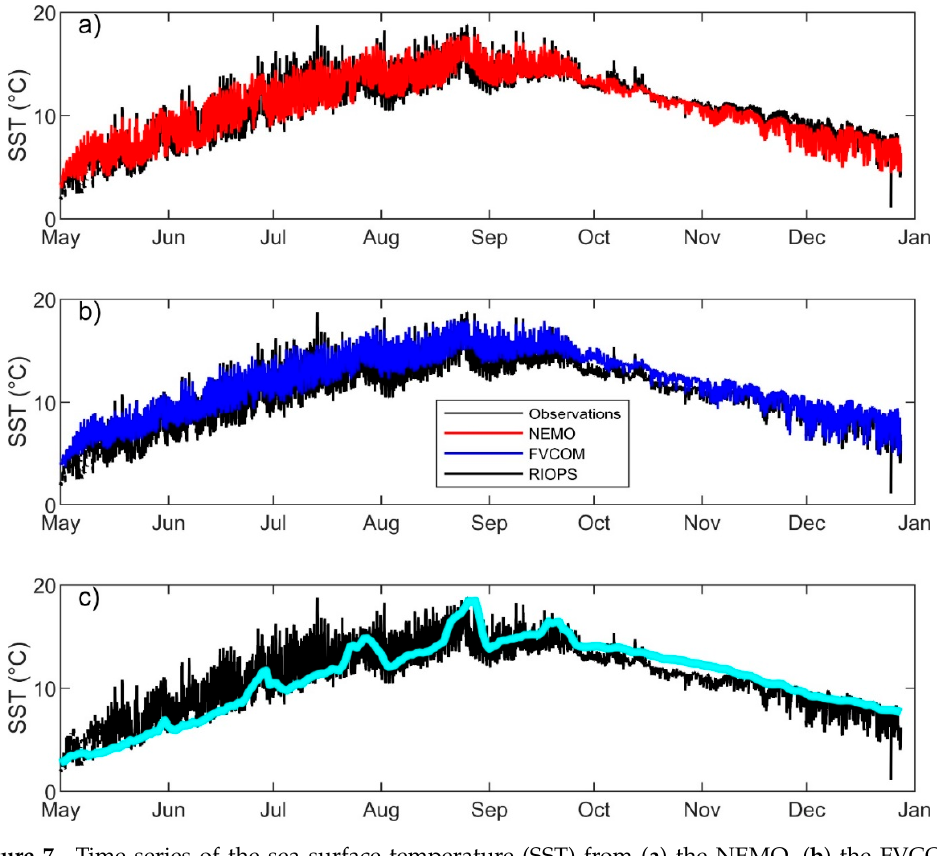
Figure 7. Time series of the sea surface temperature (SST) from ( a ) the NEMO, ( b ) the FVCOM, and ( c ) the RIOPS compared to the observed SST at the SmartAtlantic Buoy. RIOPS times series is based on daily output.